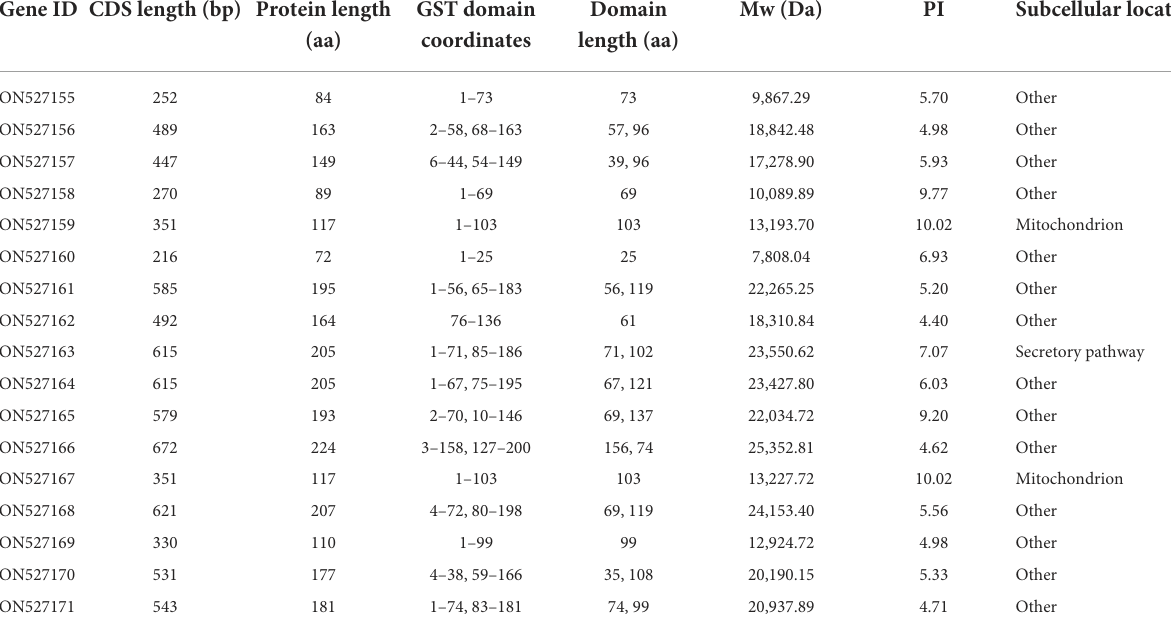
TABLE 1 Annotations features for glutathione transferase of Spirometra mansoni . Gene ID CDS length (bp) Protein